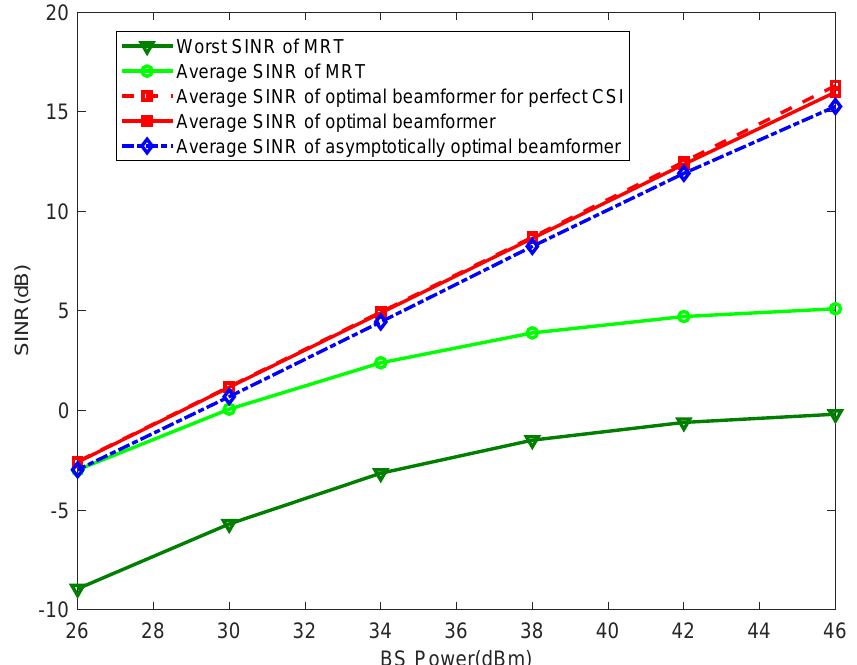
Figure 3. The achieved SINR among several algorithms with regard to P ( M = 64, I = 4, K = 3, r = 0.7, τ = 0.07).